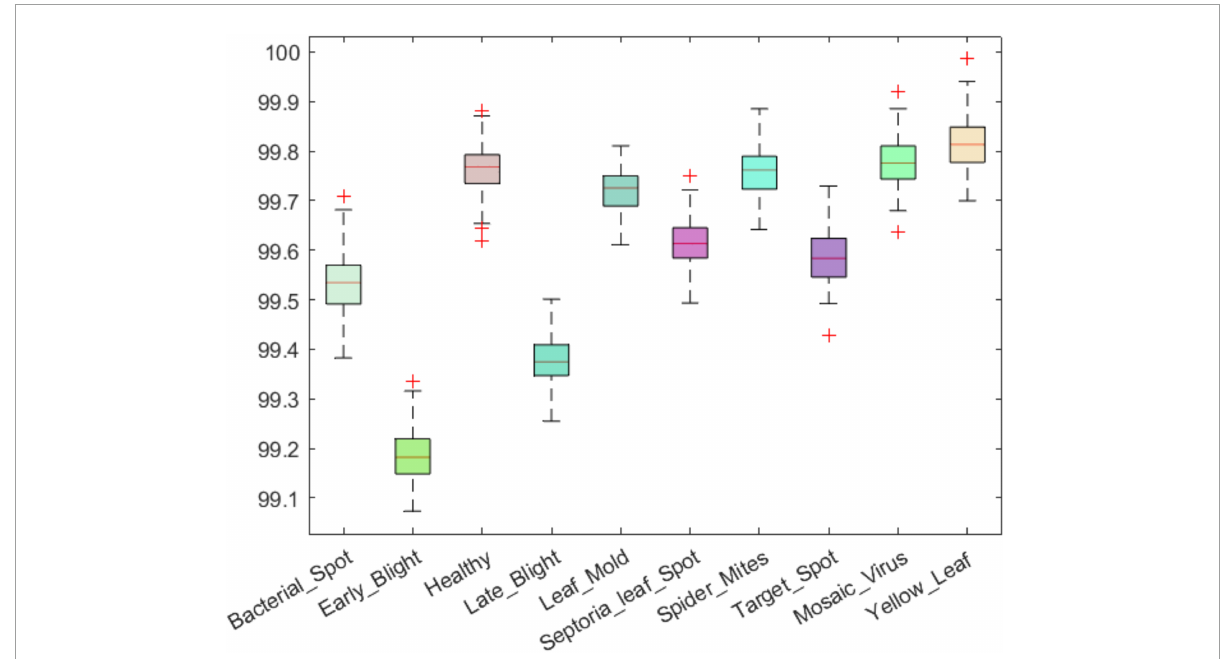
FIGURE8 A pictorial depiction of the class-wise precision values obtained for the DenseNet-77-based CornerNet model.